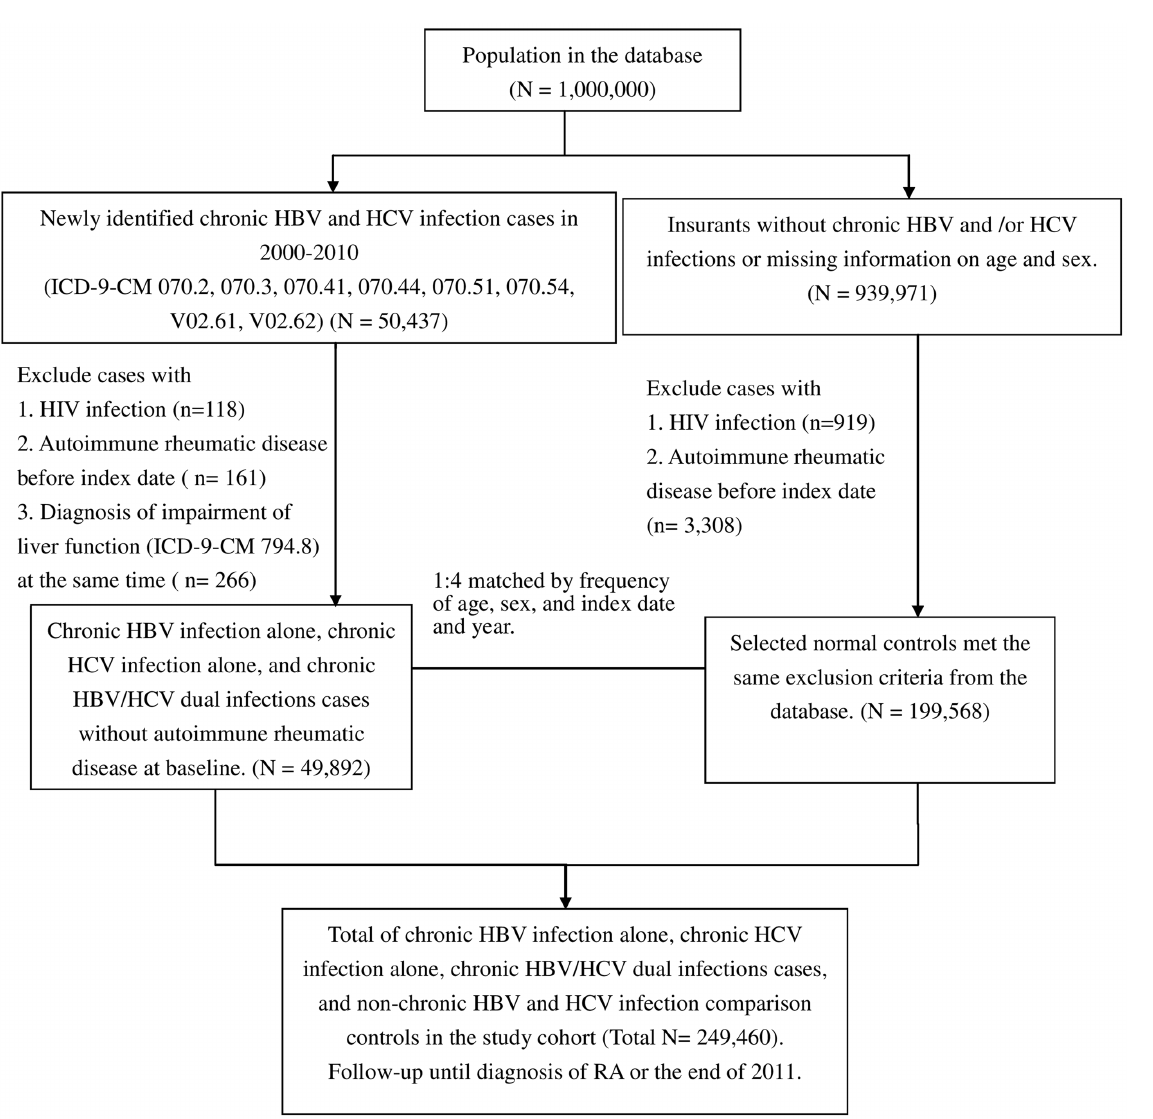
Figure 1. Study participant